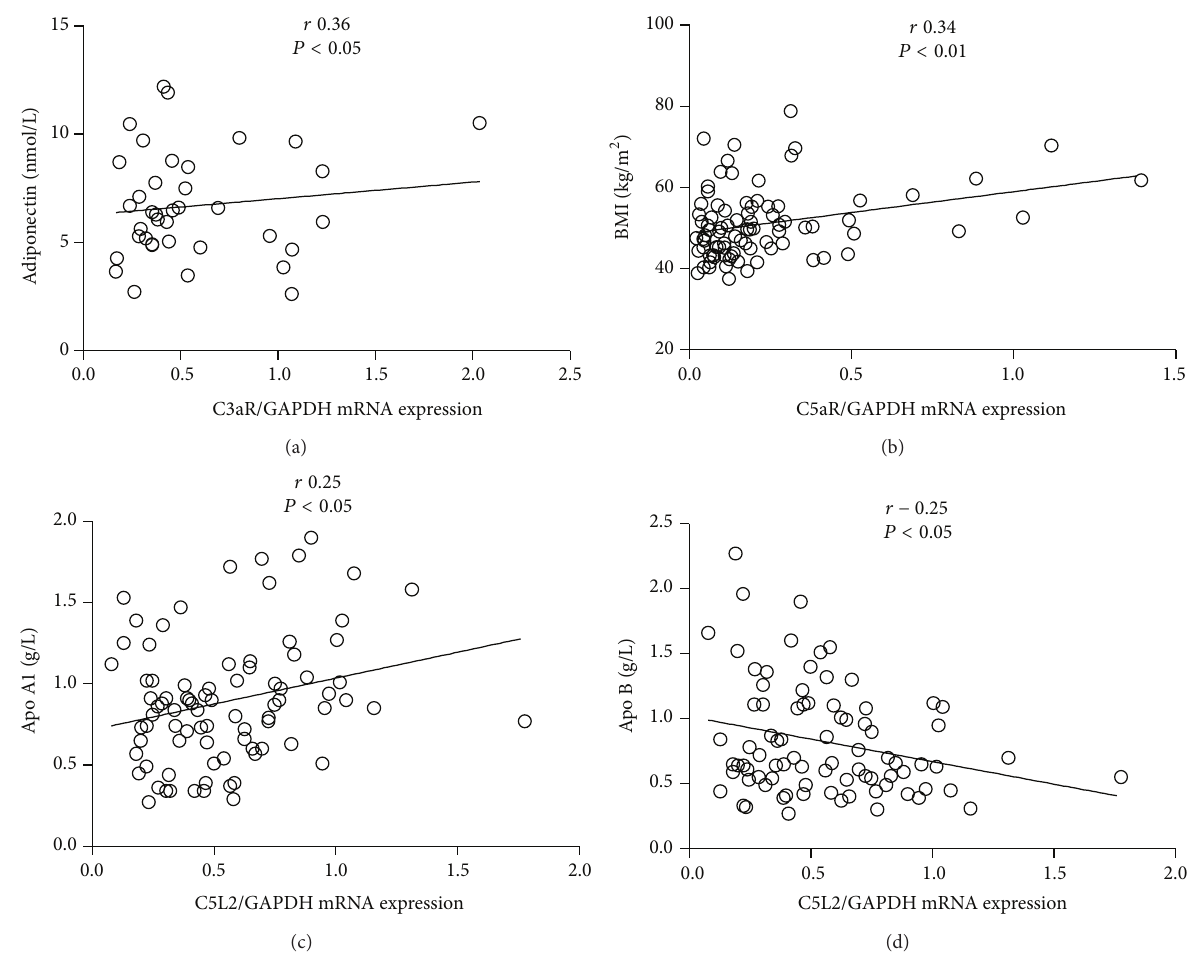
Figure 2: Hepatic mRNA Expression relative to metabolic parameters. (a)–(d): Linear plot correlations of hepatic mRNA expressions and metabolic parameters. mRNA was extracted from liver biopsies and reverse-transcribed to cDNA and gene expression was evaluated by RT-PCR with the indicated primers with all results expressed relative to GAPDH using the ΔΔ Ct method as described in detail in Section 2.